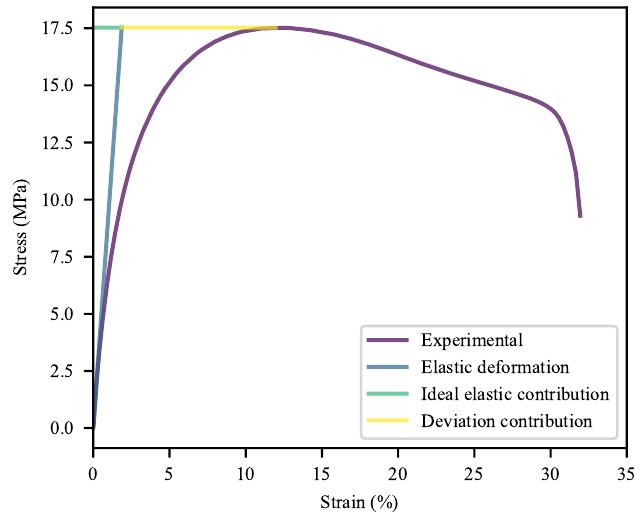
Figure 10. Determination of a deviation contribution, based on a stress-strain curve of a REF specimen of Formulation 1 under the DIC test conditions.